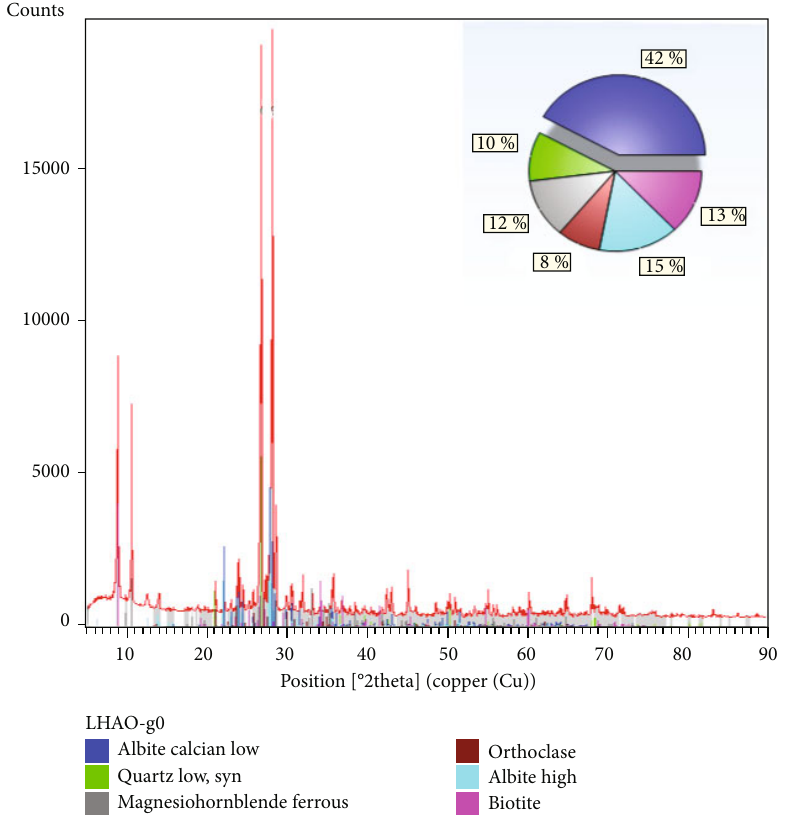
Figure 3: XRD analysis of the mineral composition of the rock power before F-T